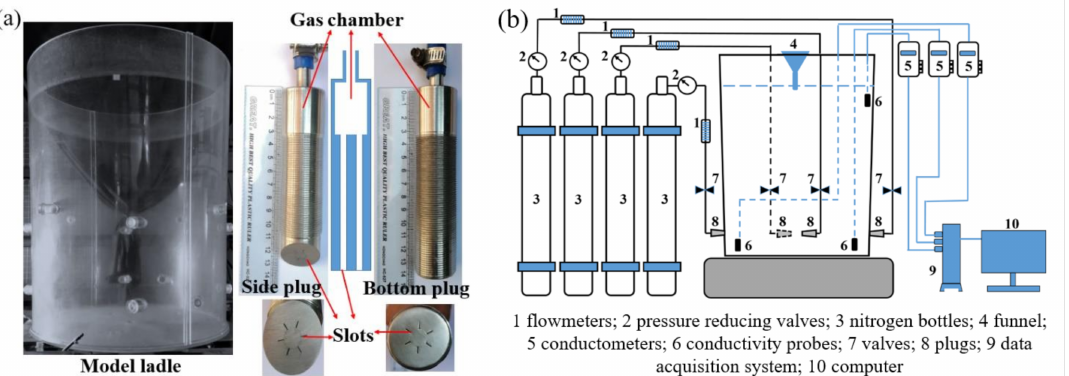
Figure 1. Experimental equipment: ( a ) ladle and plugs of model; ( b ) experimental